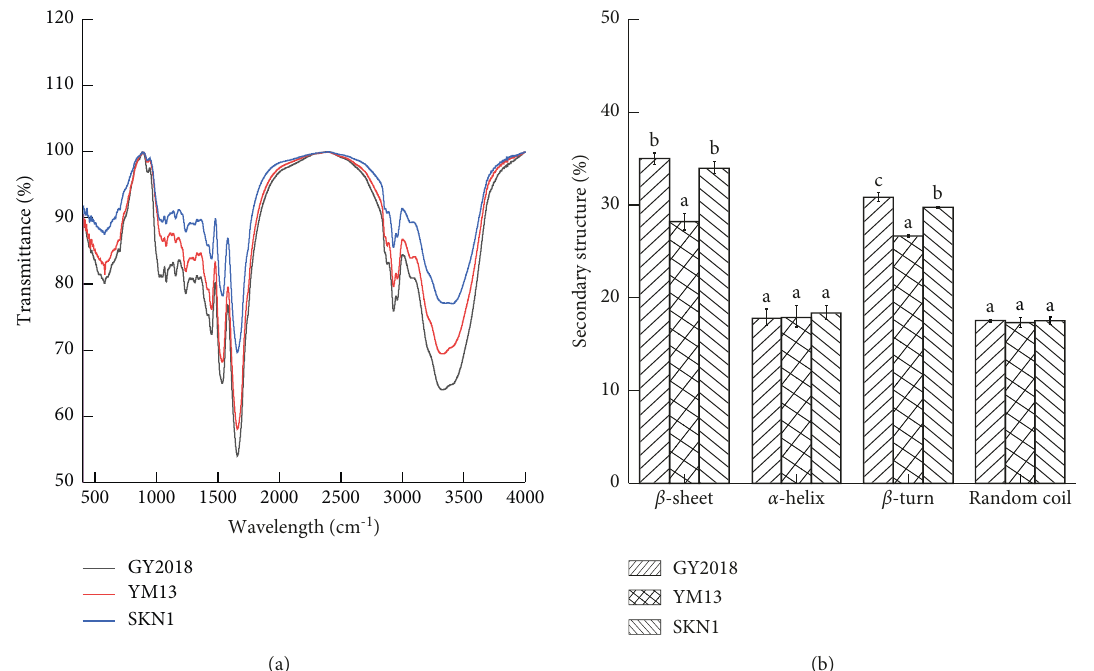
Figure 6: Fourier transform infrared (FTIR) spectrometer (a) and secondary structures (b) of samples from GY2018, YM13, and SKN1. Different lowercase letters significantly differed between the same secondary structures with different varieties ( p < 0 . 05).